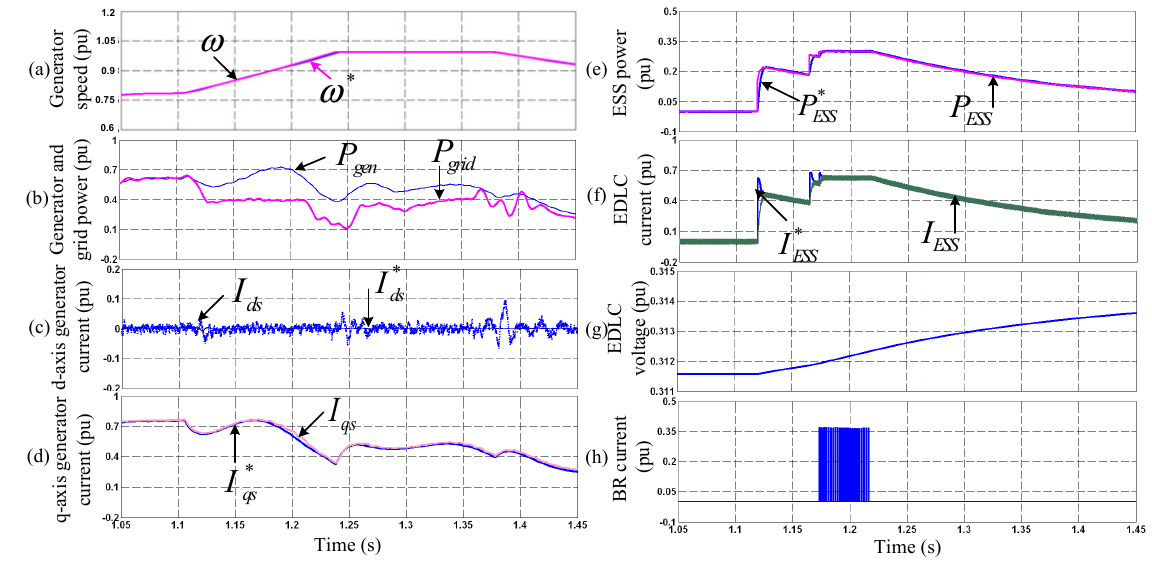
Figure 6. Control performances of the PMSG, ESS, and BRs at the fault. ( a ) WTS speed. ( b ) Grid and PMSG powers. ( c ) d-axis components of PMSG current. ( d ) q-axis components of PMSG current. ( e ) ESS powers. ( f ) EDLC currents. ( g ) EDLC voltage. ( h ) Current of BRs.